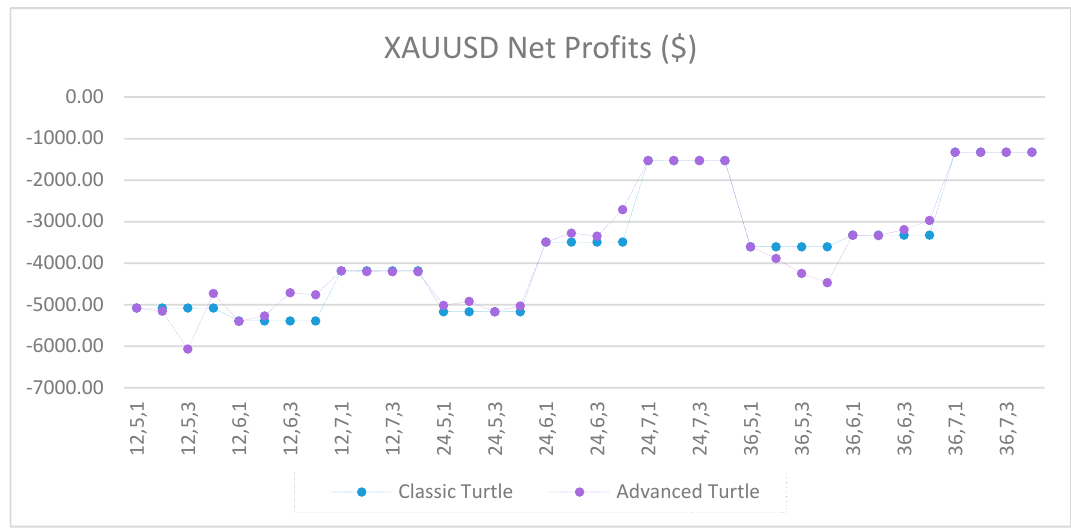
Figure A59. Net profits of XAUUSD between the classic and the advanced Turtle systems for every combination of N, X, Y for the slow parameters (80, 160), where X ≥ 5.